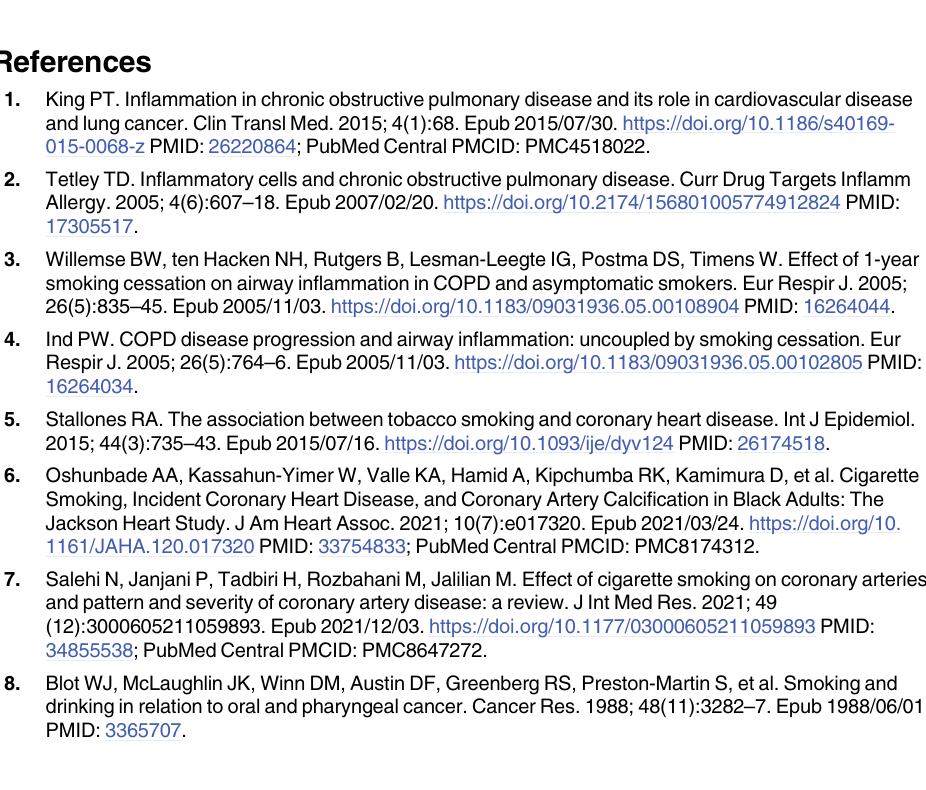
S1 Fig. Original western blot images for Fig 1B. S2 Fig. Original western blot images for Fig 4B. S3 Fig. Original western blot images for Fig